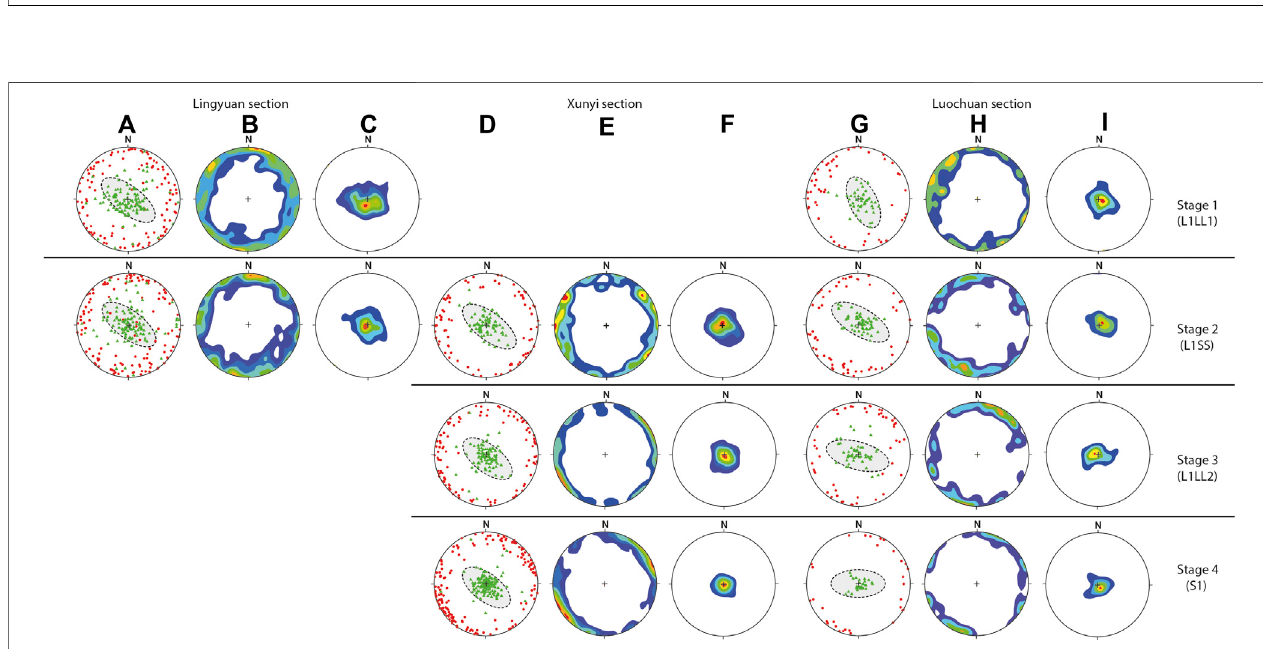
FIGURE 8| Anisotropy of magnetic susceptibilityorientations for the LY, XY, and LC sections: stereographic projection (A,D,G) ofK max (red dots) and K min (green triangles); contours of K max (B,E,H) and K min (C,F,I) .